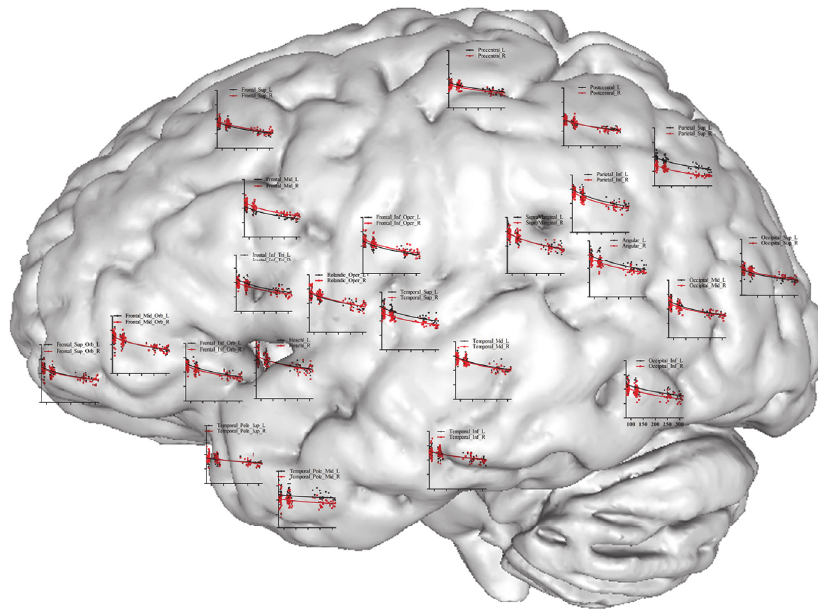
Figure 3: Scatterplot map of cortical lobes. Shown is a surface rendering of a human brain with scatterplots for GMV at various regions over the cortical lobes where the measurements were taken. Age in months is represented on the x -axis (range 50 to 300) and GMV on the y -axis (range 0.2 to 1.0). Red lines represent left hemisphere and black lines represent right hemisphere.